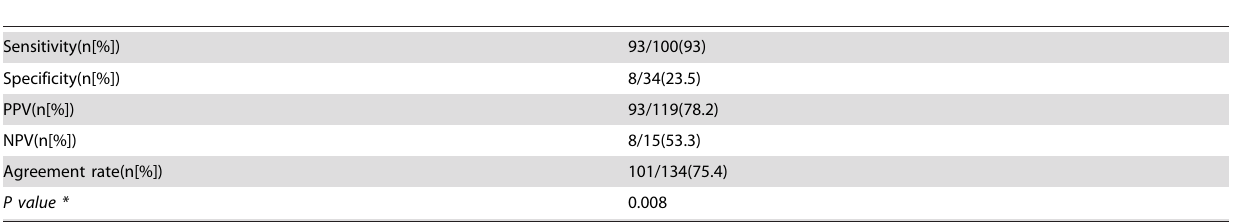
Table 3. Summary of statistical analysis of Flot-2 immunostaining for the detection of NPC patients with lymph node